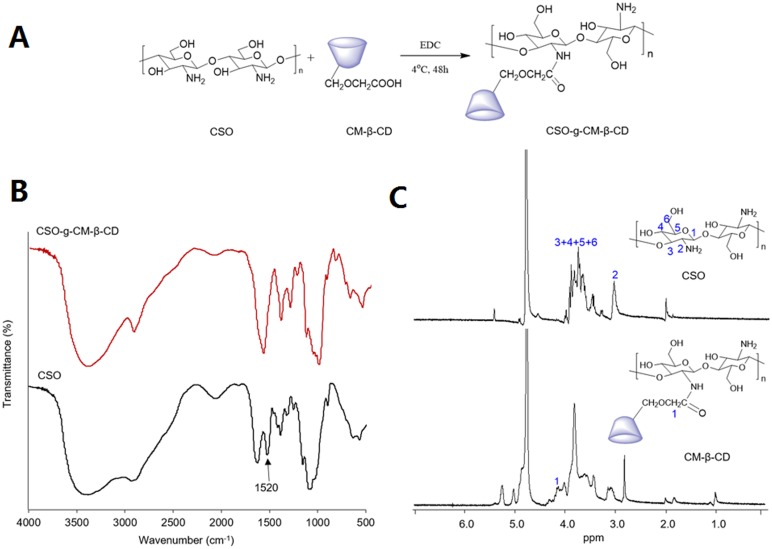
CSO-g-CM-β-CD synthesis and characterization.Synthetic route of CSO-g-CM-β-CD (A); FT-IR spectra of CSO-g-CM-β-CD and CSO (B) and 1H-NMR spectra of CSO and CSO-g-CM-β-CD in D2O (C).